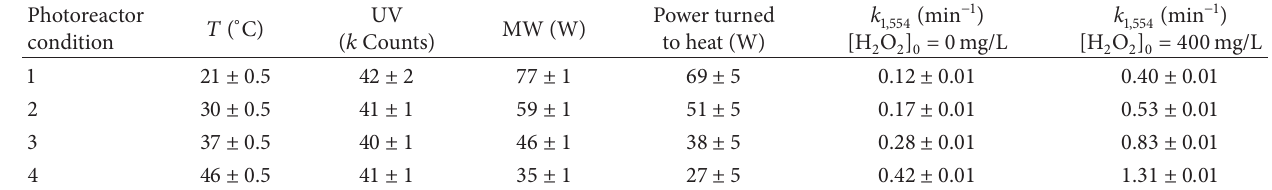
Table 1: Experimental conditions at controlled temperatures and with the measured rate constant.